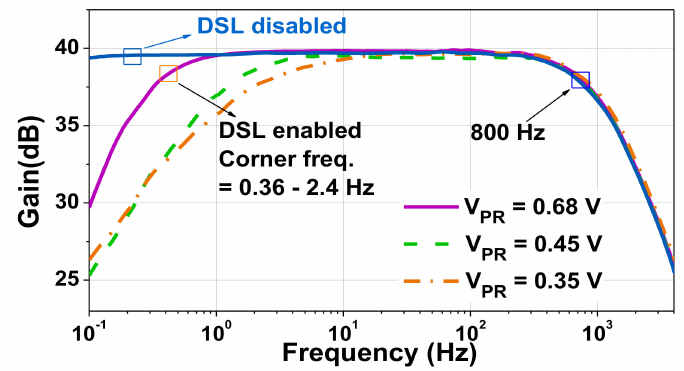
Figure 12. Chip microphotograph of the proposed CCIA.